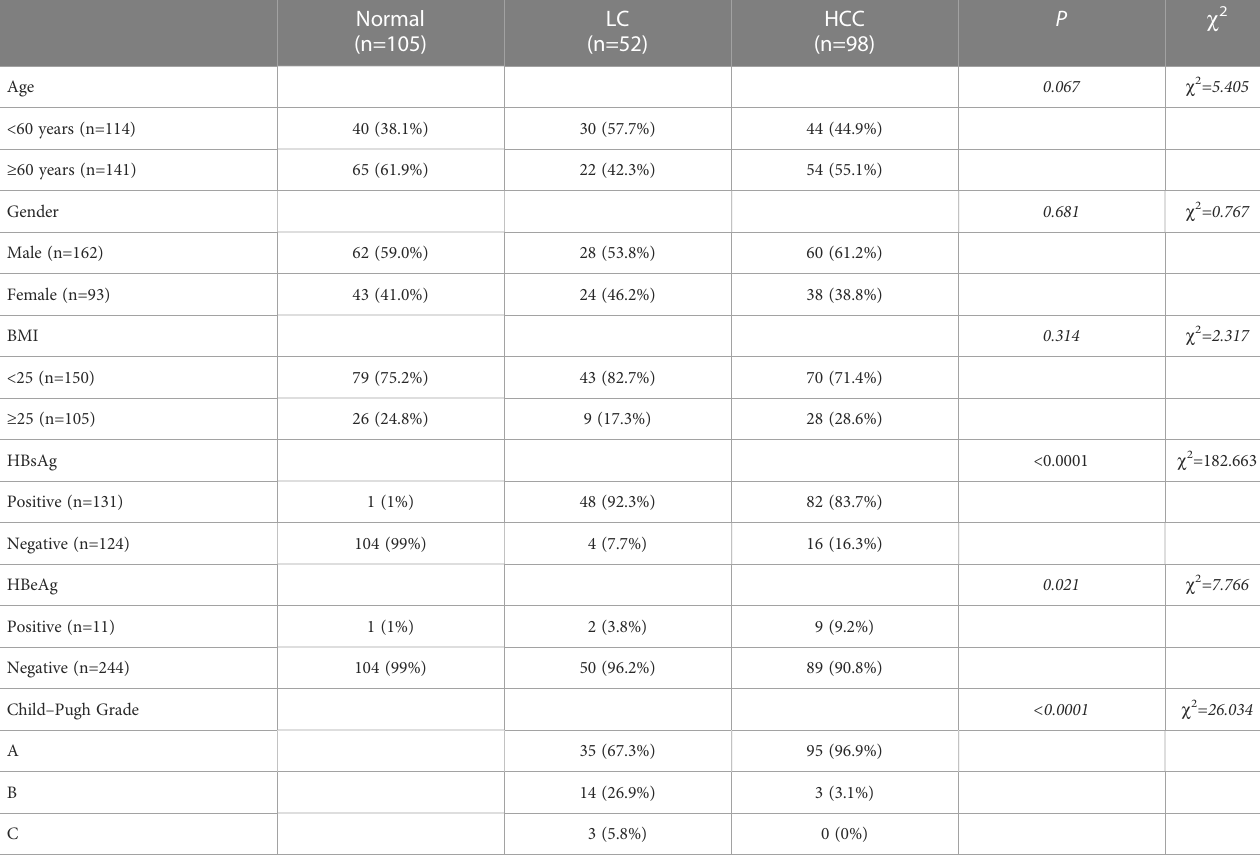
TABLE 1 Demographic, clinical, and some biochemical characteristics of the study